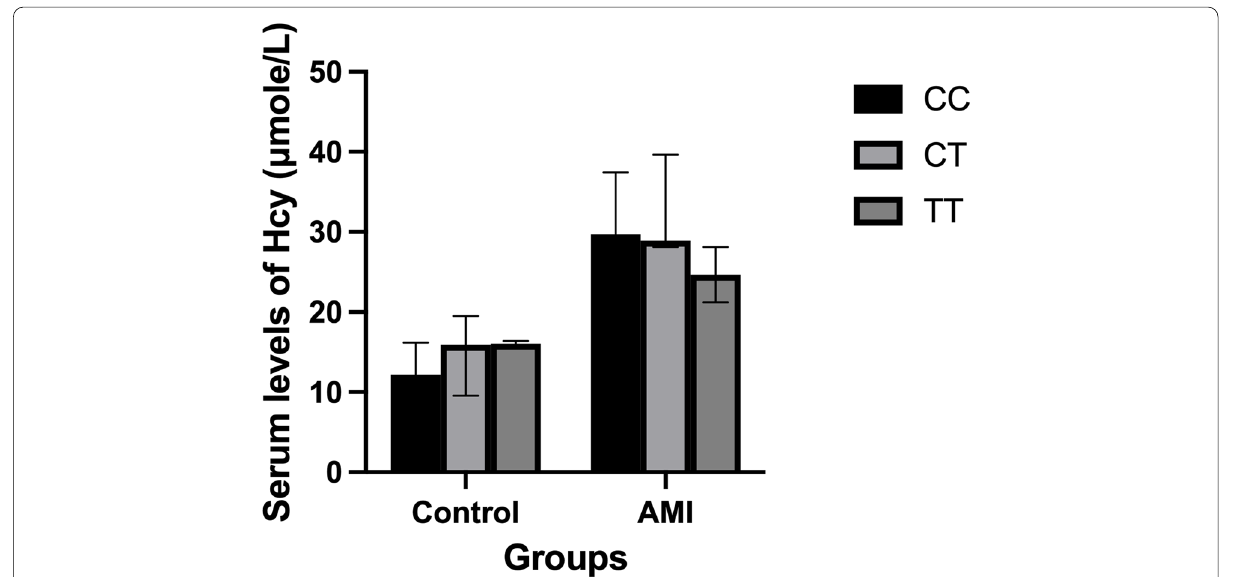
Fig. 3 The median serum Hcy concentrations among all genotypes in both control and